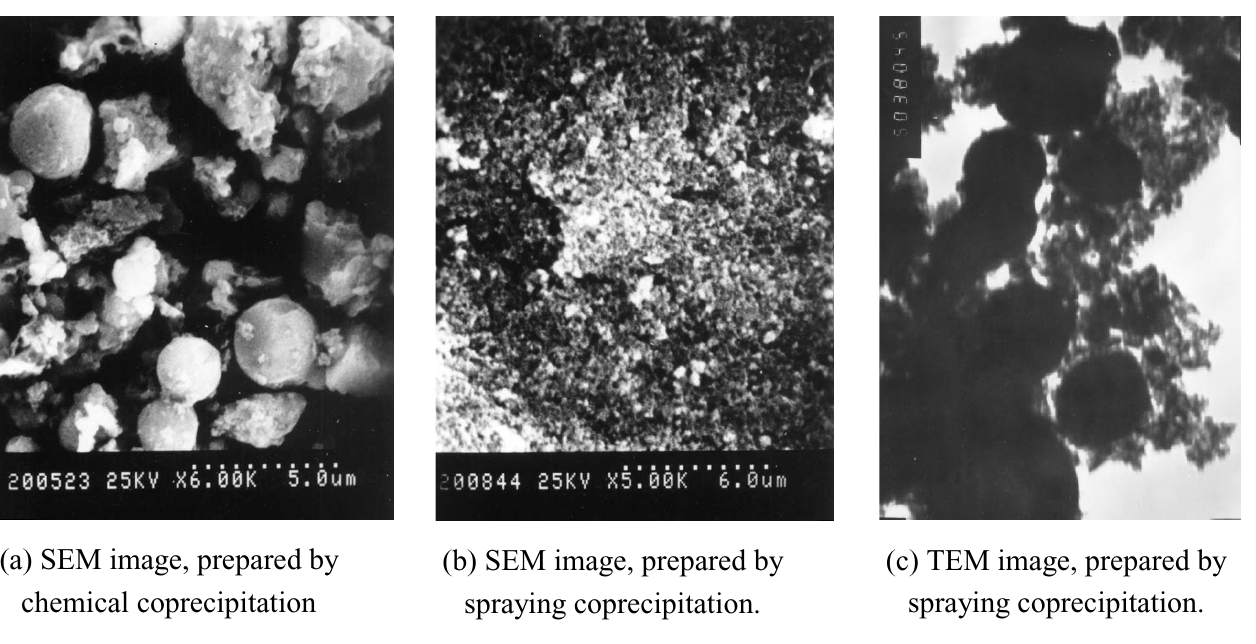
Figure 4. Electron diffraction image of ZnGa